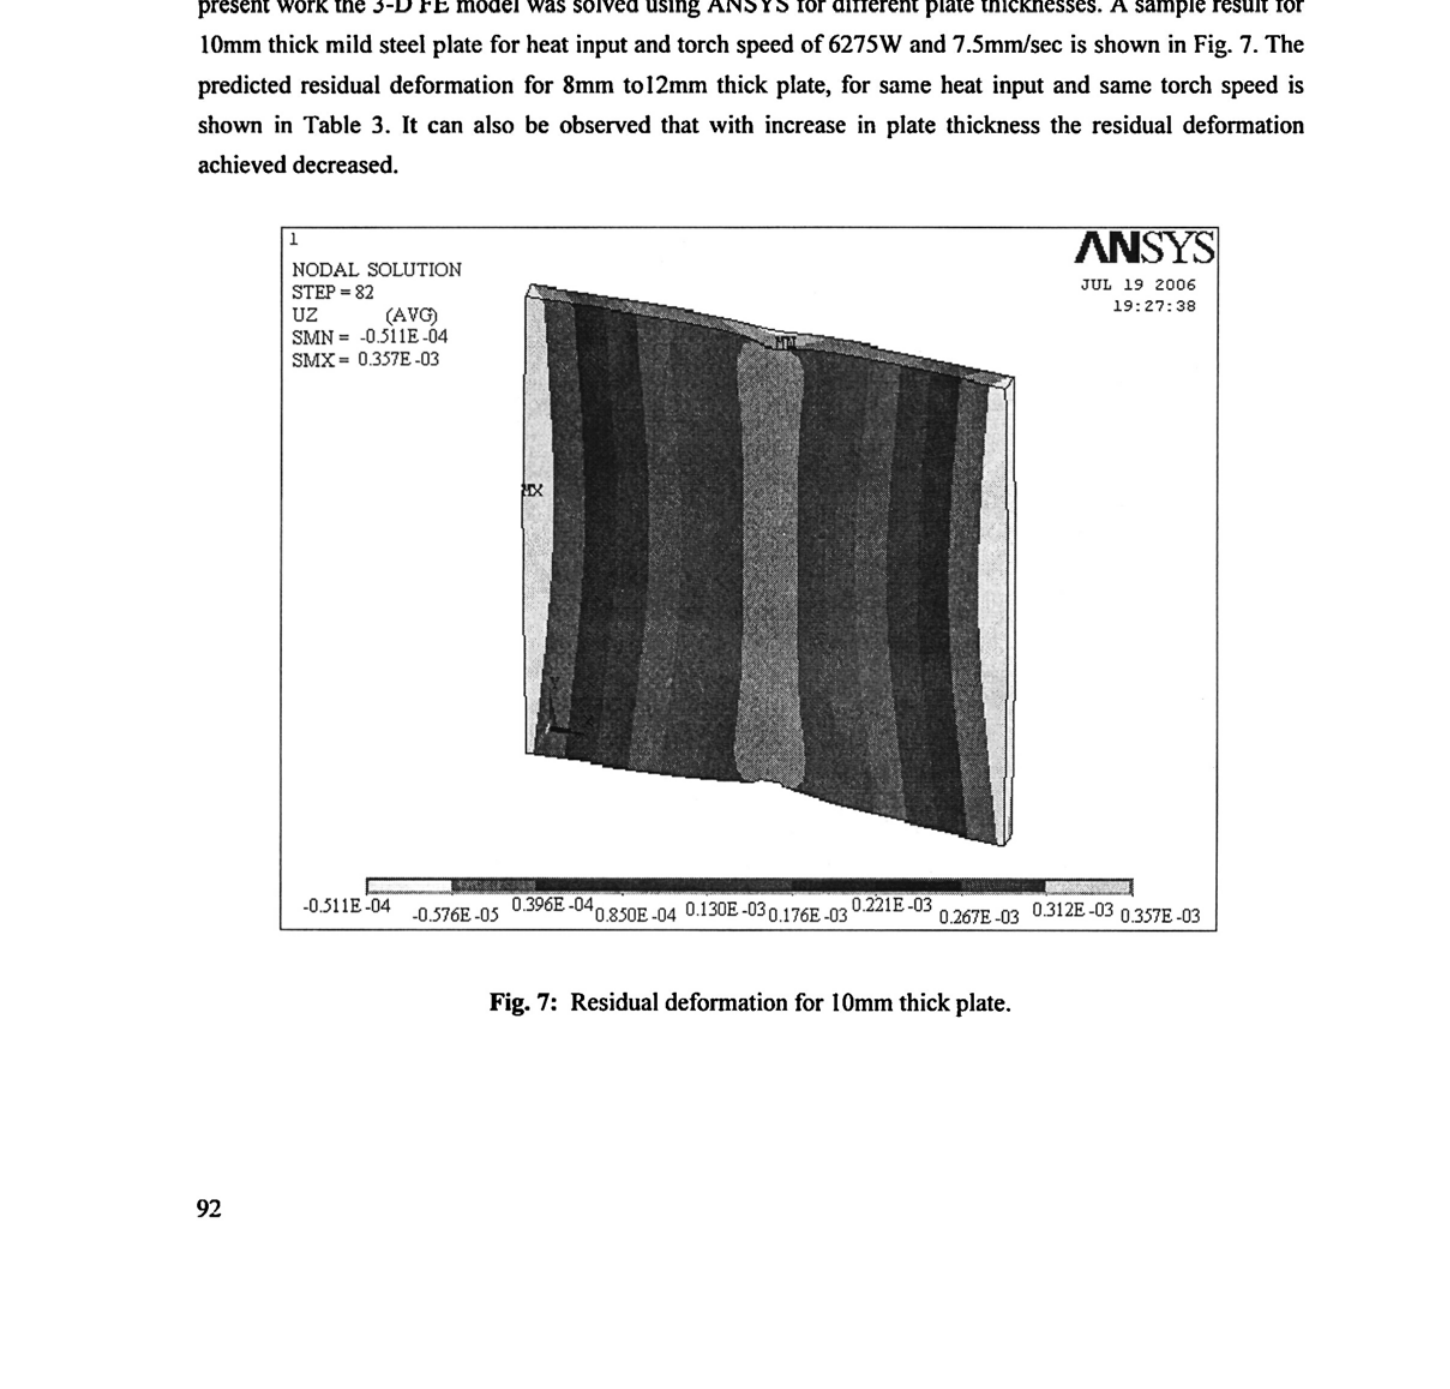
Fig. 7: Residual deformation for 10mm thick